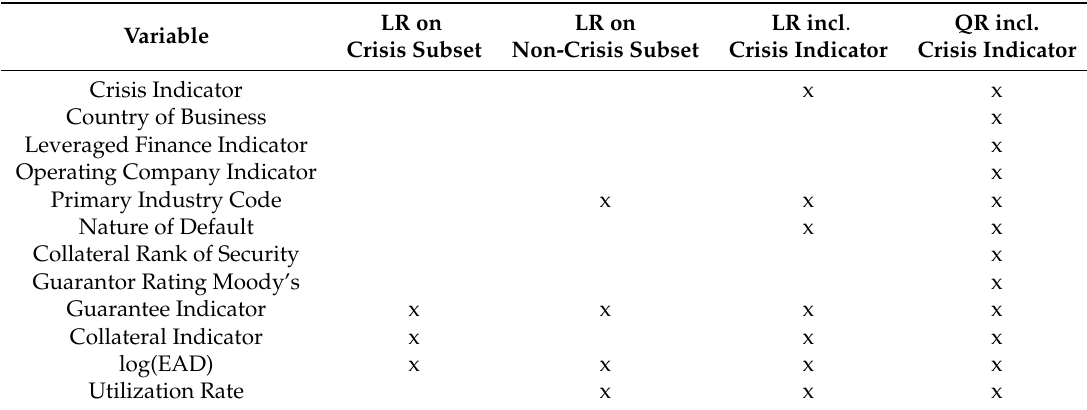
Table 2. Included attributes in the linear regression models (LR) on the crisis/non-crisis subset resp. the entire subset including the Crisis Indicator and in the quantile regression model (QR) including the Crisis